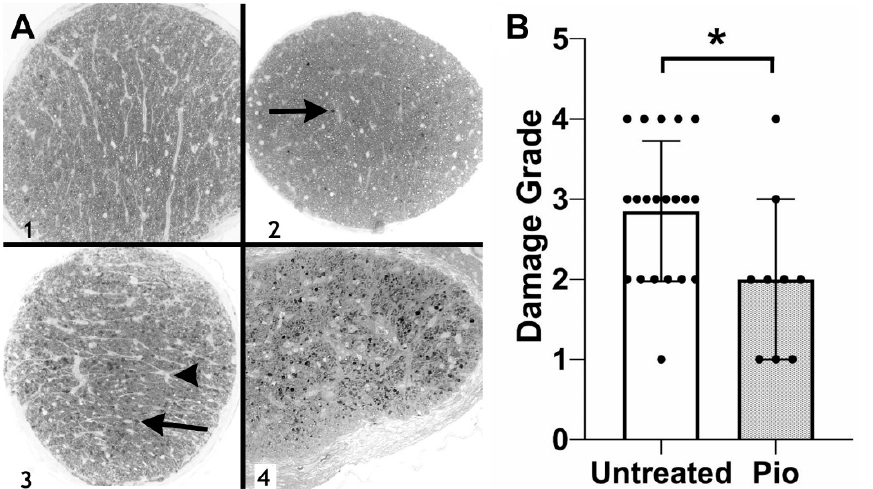
Figure 2. Optic nerve damage in DBA2/J mice. ( A ) Examples of optic nerve damage grades. A grade of 1 indicates a normal optic nerve, whereas a grade of 4 is assigned to optic nerves displaying severe damage and numerous PPD stained axons (arrows) and areas of gliosis (arrowhead). ( B ) Grading of optic nerve damage demonstrates a protective effect in pioglitazone (Pio)-treated mice ( p = 0.0334). Each dot represents one optic nerve. *: p < 0.05